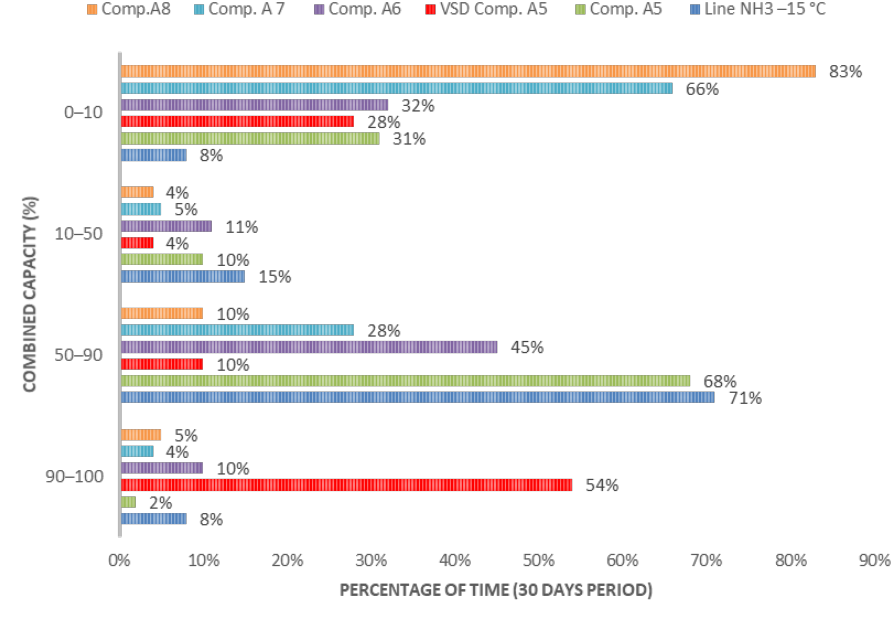
Figure 11. Capacity analysis for the −15 °C circuit.